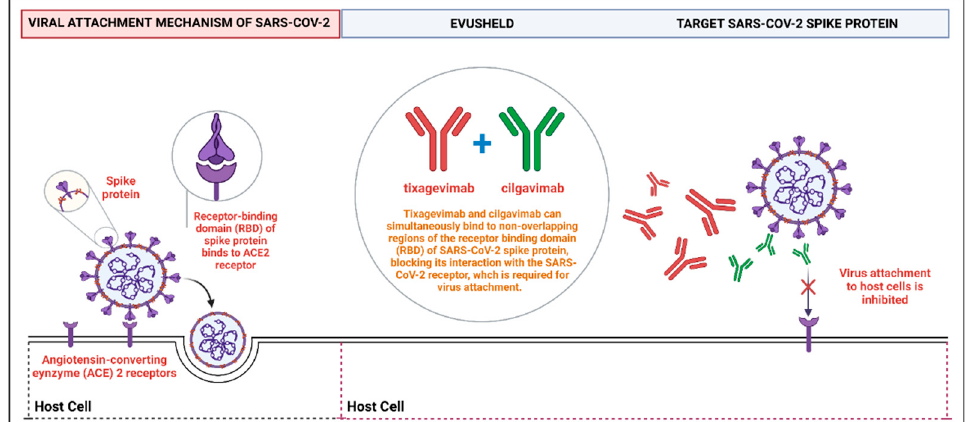
Figure 1. A schematic representation shows how TGM/CGM can simultaneously bind to the non- overlapping regions of the RBD of SARS-CoV-2 spike protein to prevent the virus attachment to human host cells. Abbreviations: RBD, receptor-binding domain; TGM/CGM, tixagevimab and cilgavimab; SARS-CoV-2, severe acute respiratory syndrome coronavirus 2.